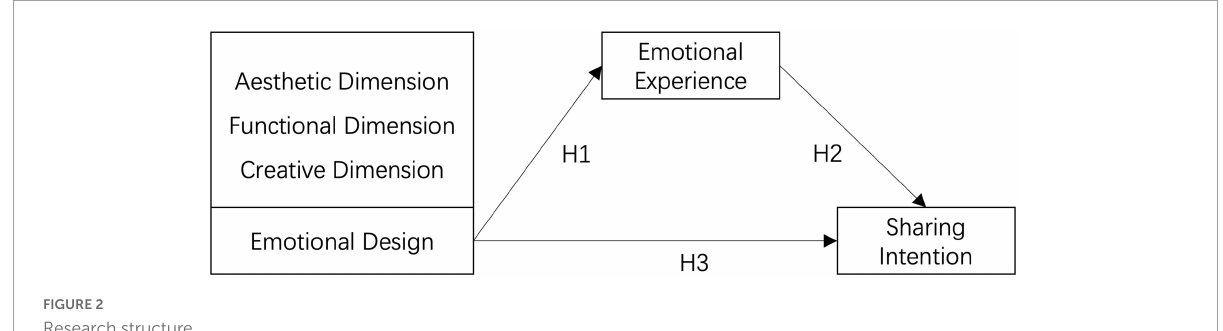
FIGURE2 Research